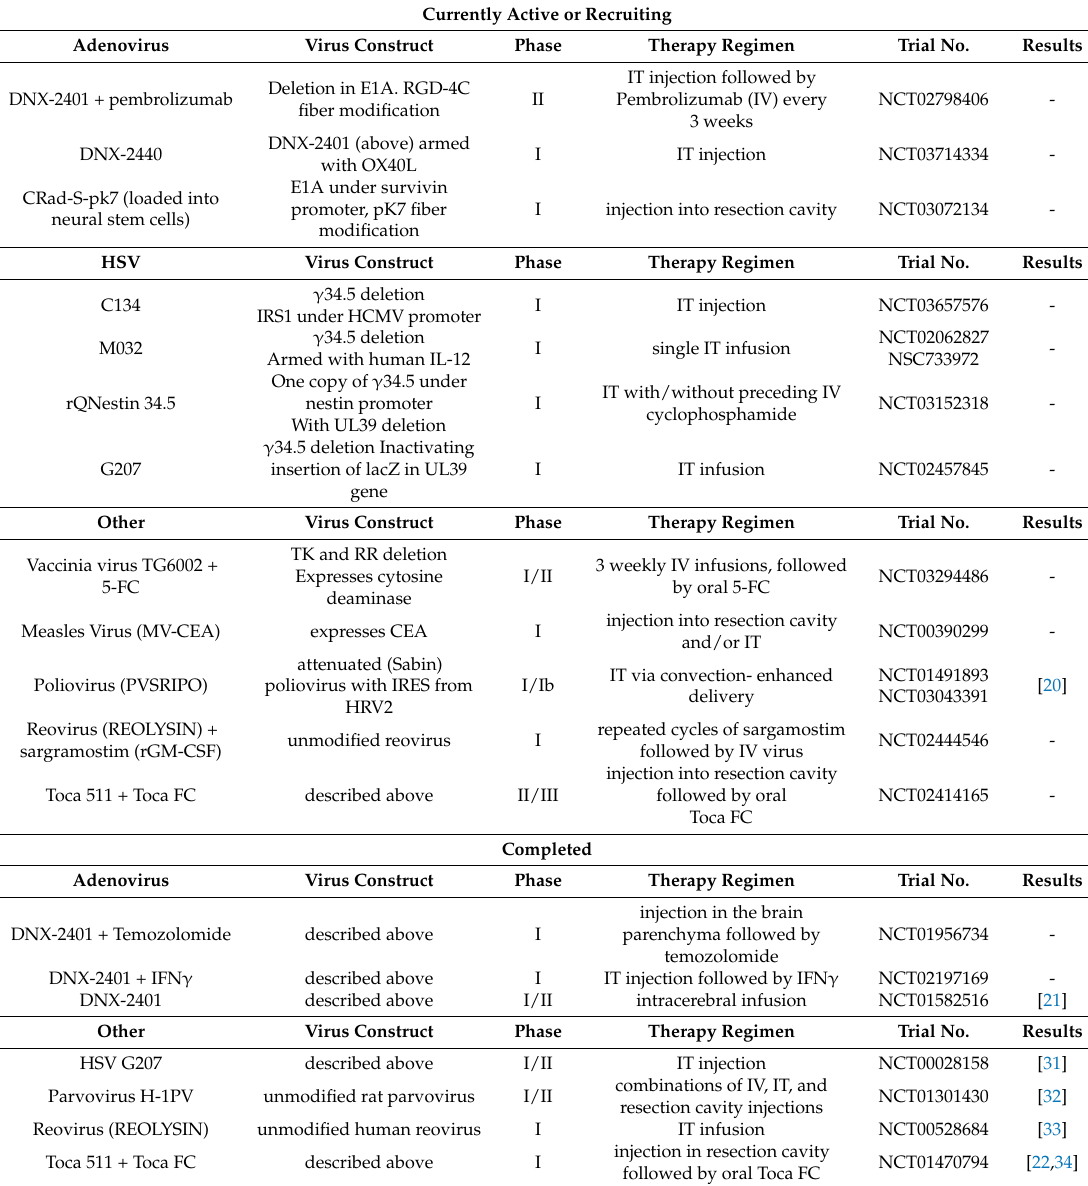
Table 1. Currently active or completed clinical trials utilizing replication-competent viruses against malignant gliomas. Search results from